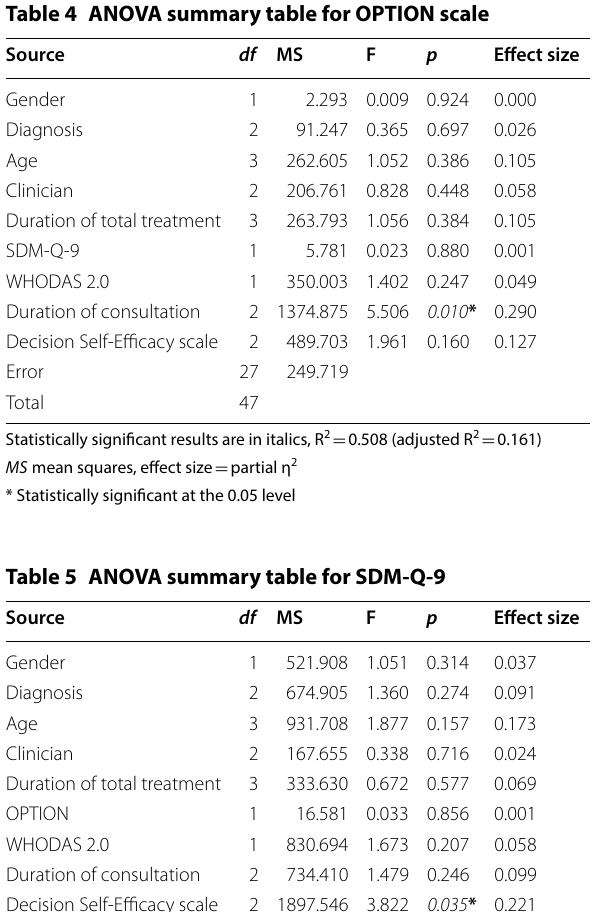
Table 4 ANOVA summary table for OPTION scale